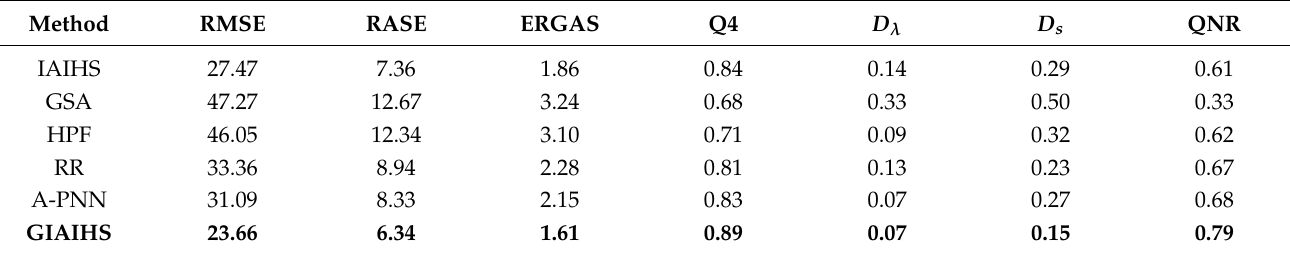
Table 2. Experiment with six PS methods on Gaofen-1 satellite